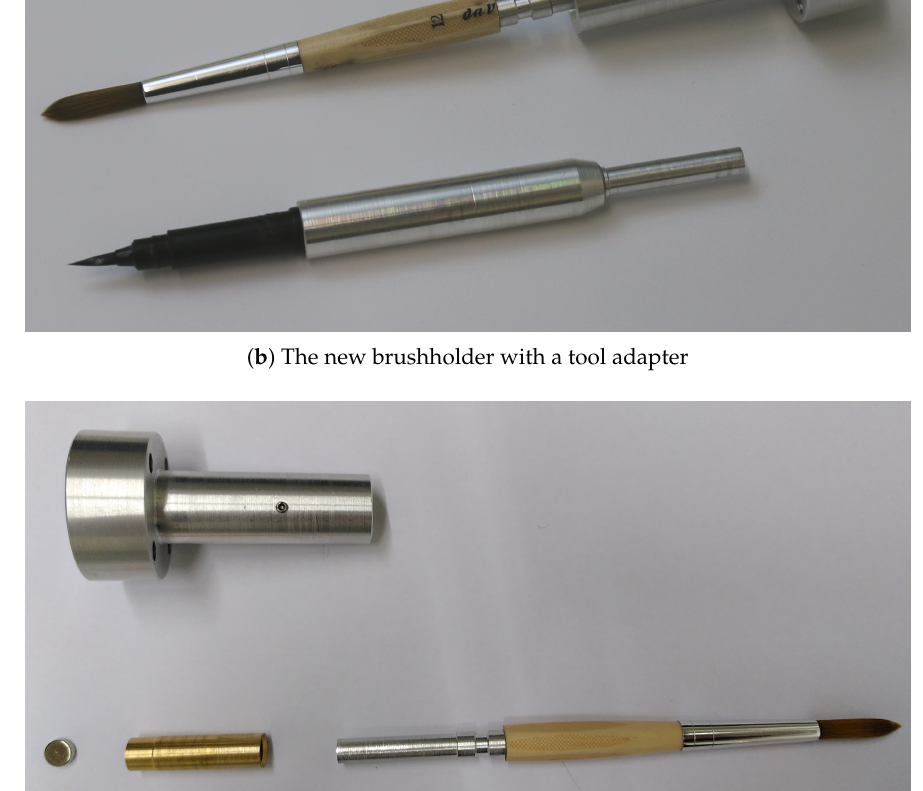
Figure 3. e-David brushholder